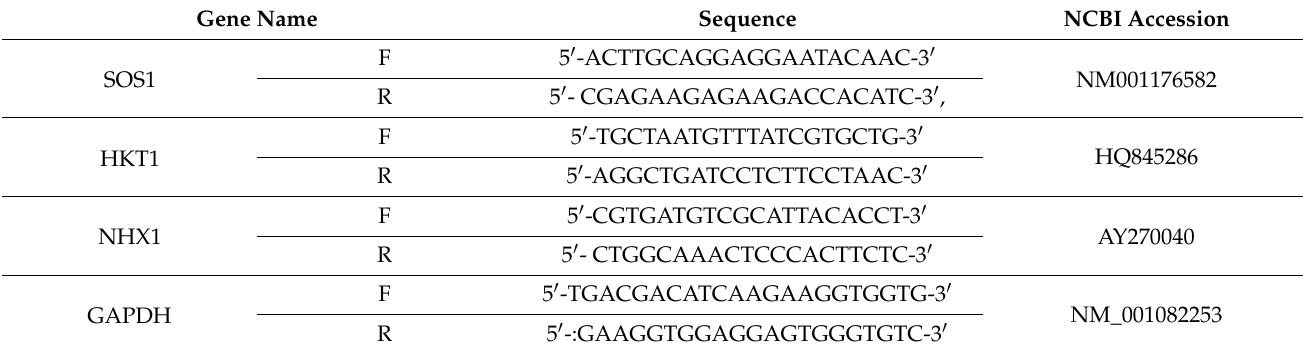
Table 1. Oligonucleaotides primer pairs used for quantitative RT-PCR